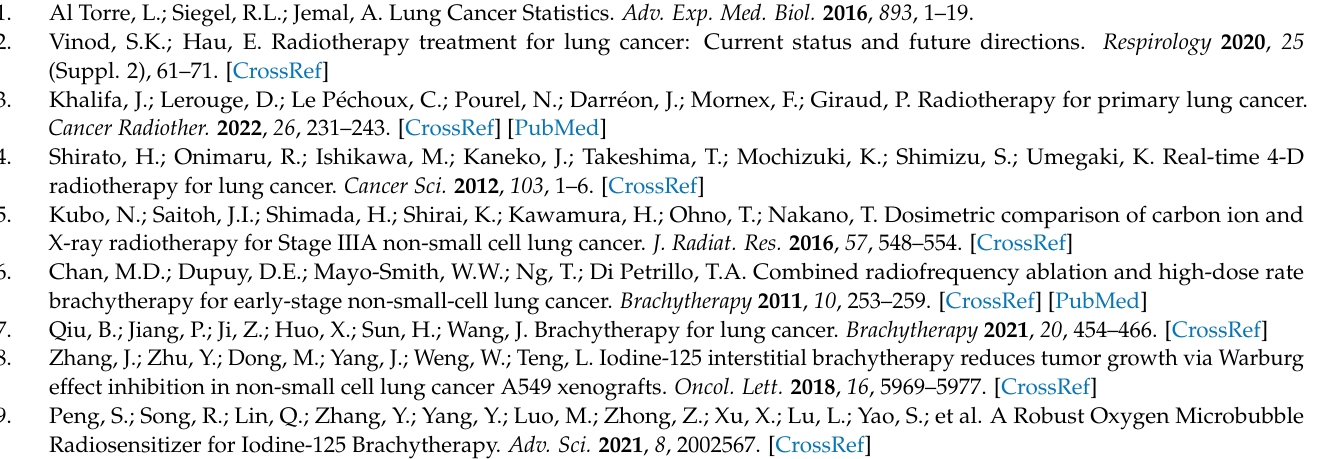
Figure S3: Cytotoxicity of free CuS-I-PEG nanotheranostics after incubation with A549 cells for 24 h; Figure S4: Photoacoustic images of CuS- 131 I-PEG nanotheranostics at tumors without 808 nm NIR laser irradiation; Table S1: Formulations with different amount of CuS, iondine and PEG, and their size and zeta potential